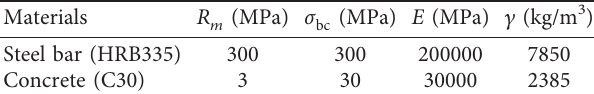
Figure 2: Schematic diagram of the test system. Table 2: Parameters of